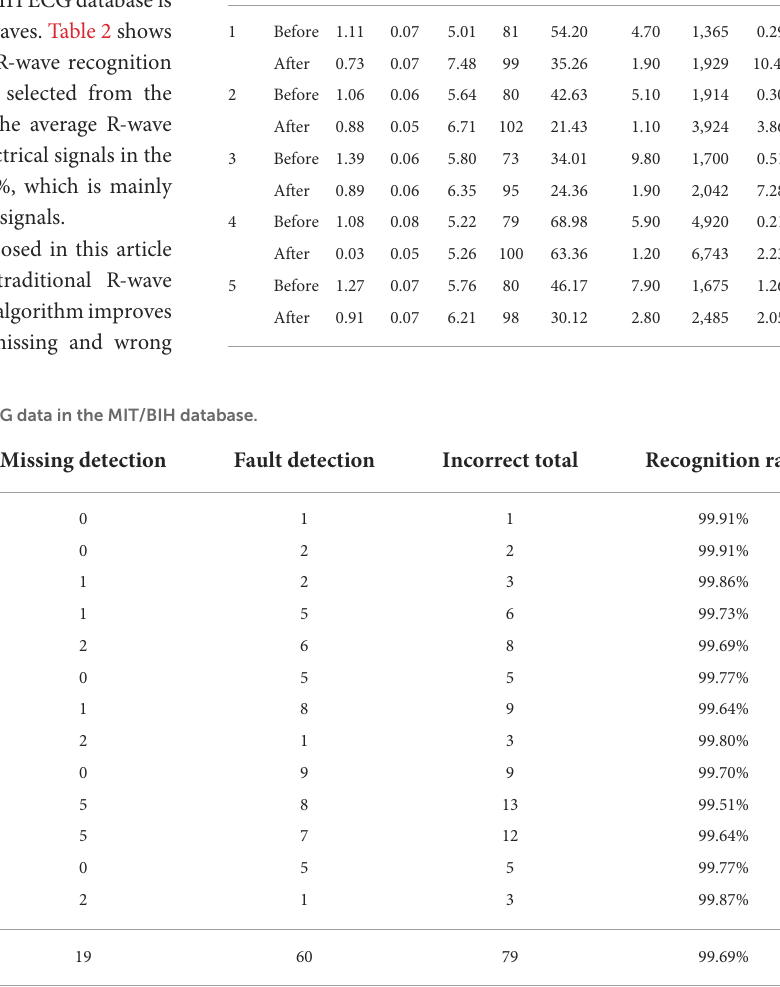
TABLE 3 Comparison of random experimental data and pressure index before and after exercise.